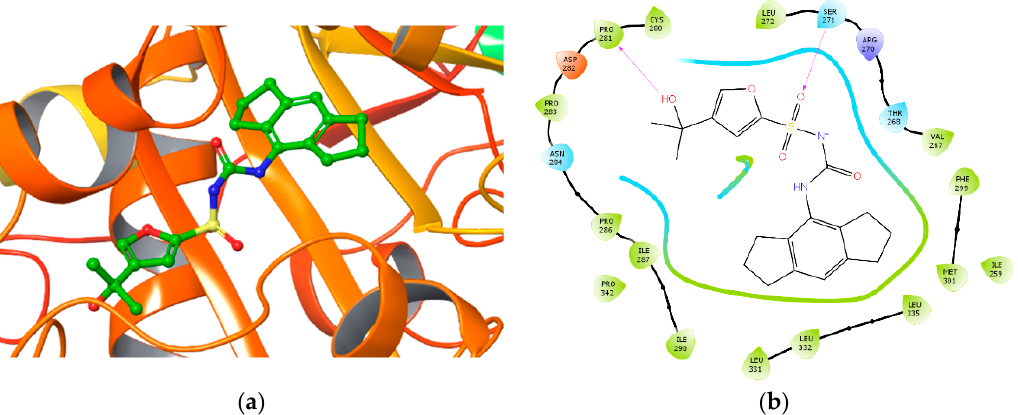
Figure 4. ( a ) The MCC950 pose from docking in XP precision on a Walker B centered grid; ( b ) Ligand interaction diagram of MCC950 from docking in XP precision on a Walker B centered region. Purple arrows refer to H-bond interactions, green lines around molecule underline non-polar regions whereas the blue ones point polar residues.